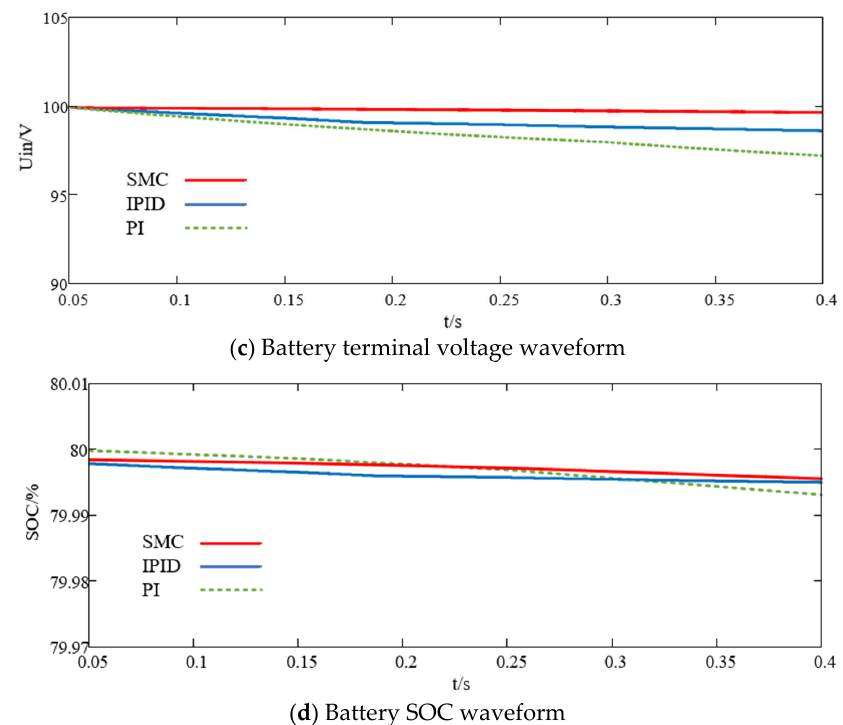
Figure 5. State response under sudden load changes, ( a ) DC bus voltage waveform, ( b ) System power waveform, ( c ) Battery terminal voltage waveform, ( d ) Battery SOC waveform. As a contrast, at 0.15 s, the bus voltage controlled by IPID drops to 198.8 V, and recovers to 200 V after 0.025 s. At 0.25 s, the bus voltage controlled by IPID drops to 199.3 V, and returns to the reference voltage after 0.02 s.